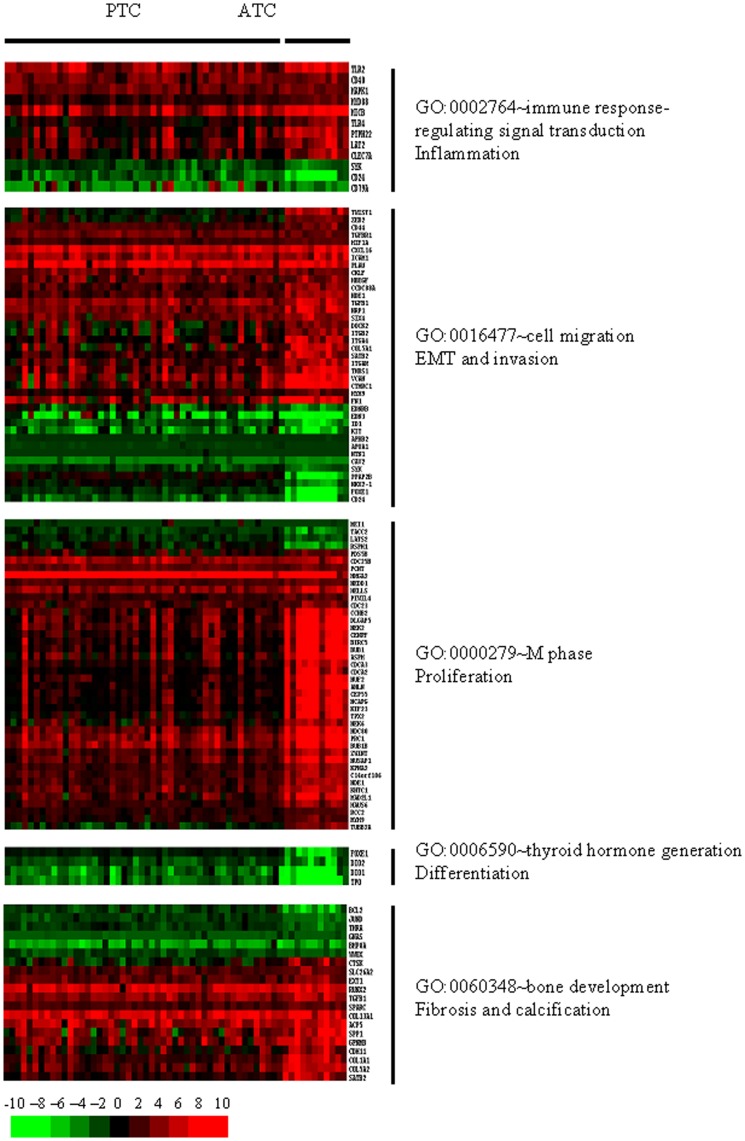
Heat map for genes belonging to some significant Gene Ontology (GO) categories (p-Value <1) corresponding to several biological processes which illustrate the more malignant character of ATC compared to PTC.